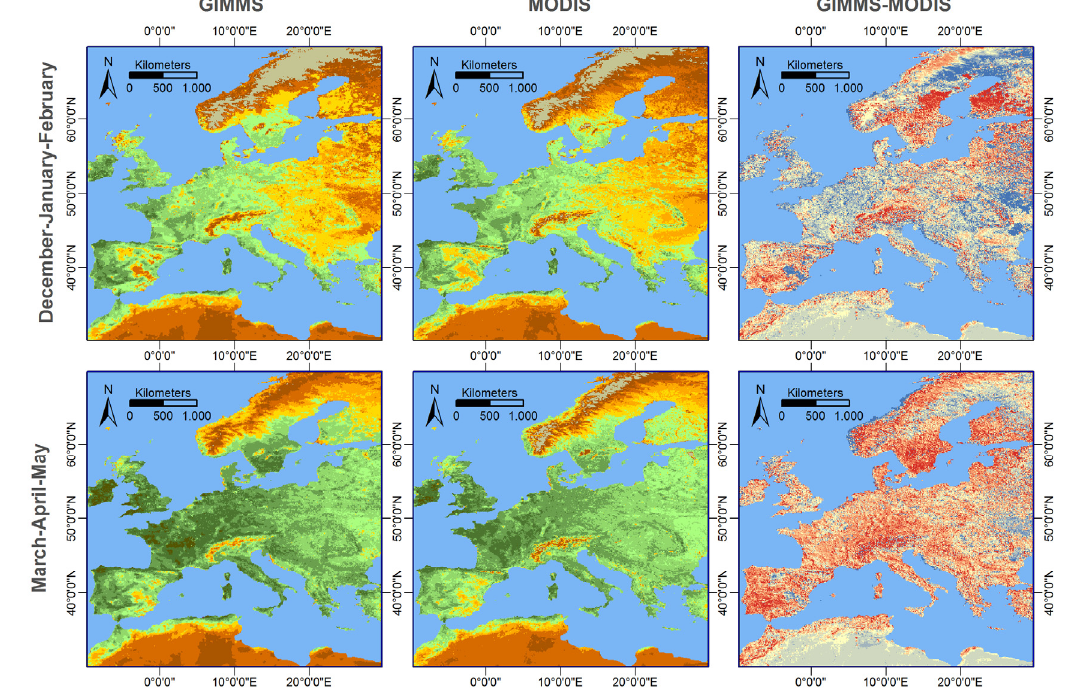
Figure 5. Spatial distribution of weekly NDVI from GIMMS ( left ) and MODIS ( center ) time series averaged over 2002–2011 for each of the four climatological seasons. ( right ) Differences between the mean NDVI of GIMMS and